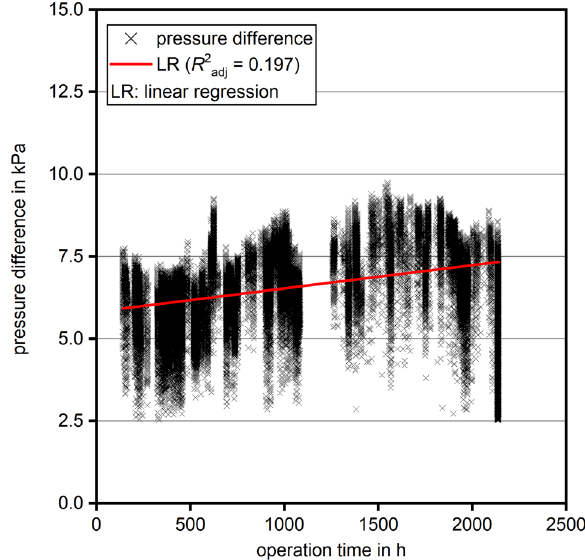
Fig. 9 Differential pressure of the diesel particulate filter of tractor 13 at 70 to 100% load and a speed range of 1700 to 2100 rpm over 2000 h without active